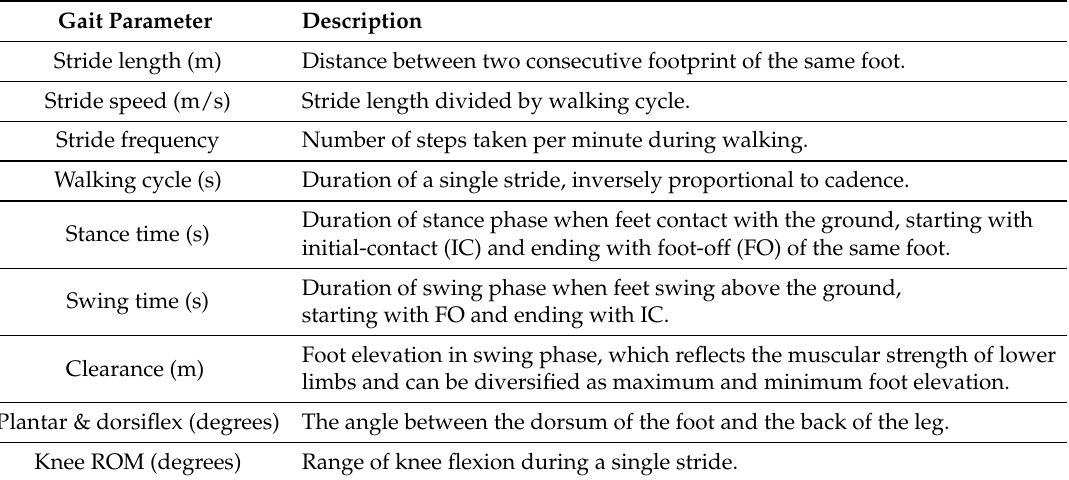
Table 1. Typical spatio-temporal gait